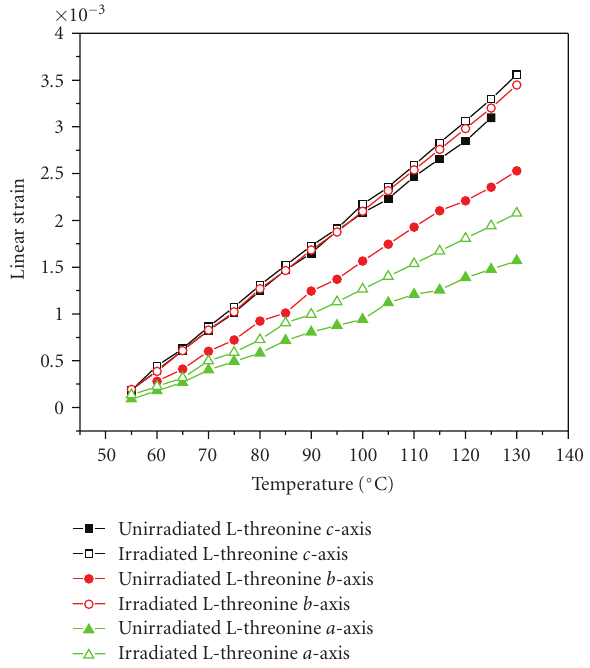
Figure 46: Linear expansion versus temperature of pure and electron-irradiated L-threonine crystal at 12 × 10 14 e/cm 2